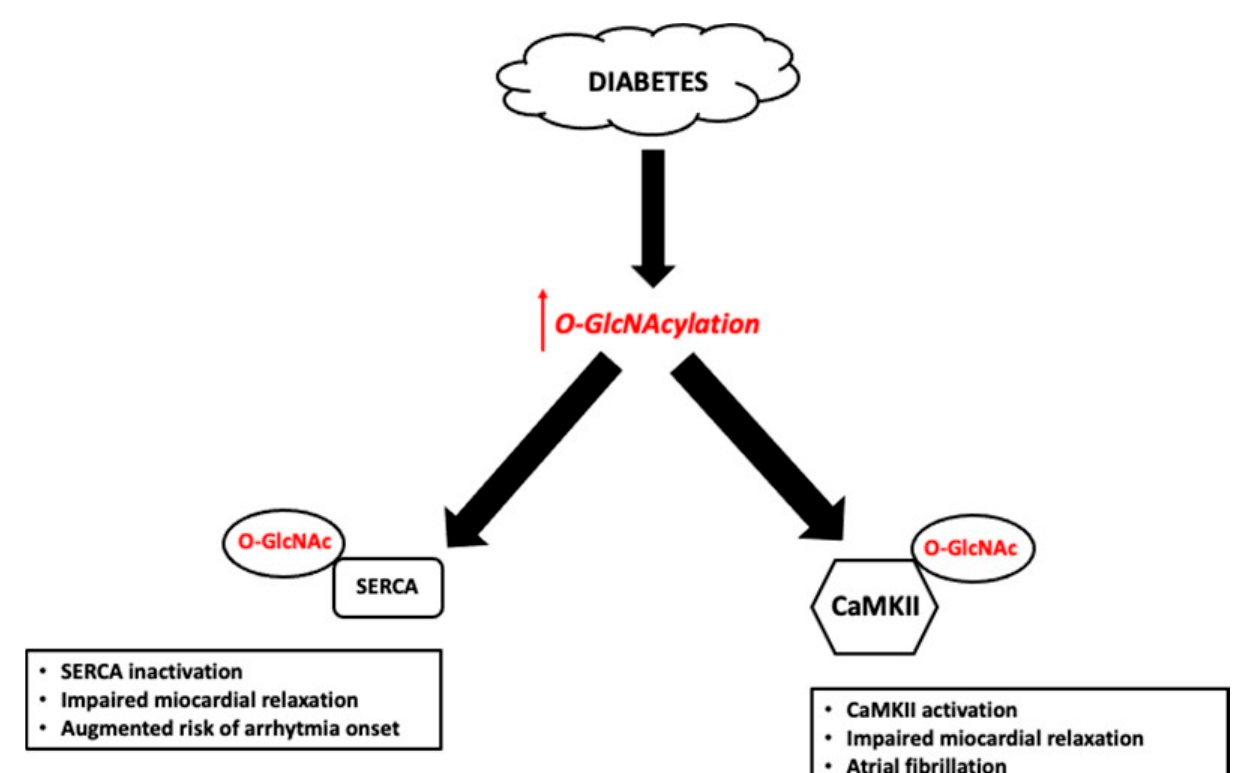
Figure 3. Pathological effects of O-GlcNAcylation on Sarco/endoplasmic reticulum Ca 2+ -Atpase (SERCA) and Ca 2+ /calmodulin-dependent protein kinase II (CaMKII). High levels of protein O-GlcNAcylation strongly reduce SERCA activity leading to impaired myocardial relaxation and/or augmented risk of arrhythmia onset. Conversely, O-GlcNAcylation of CaMKII (at Ser 280) leads to CaMKII activation with consequent alteration in myocardial relaxation and onset of atrial fibrillation.